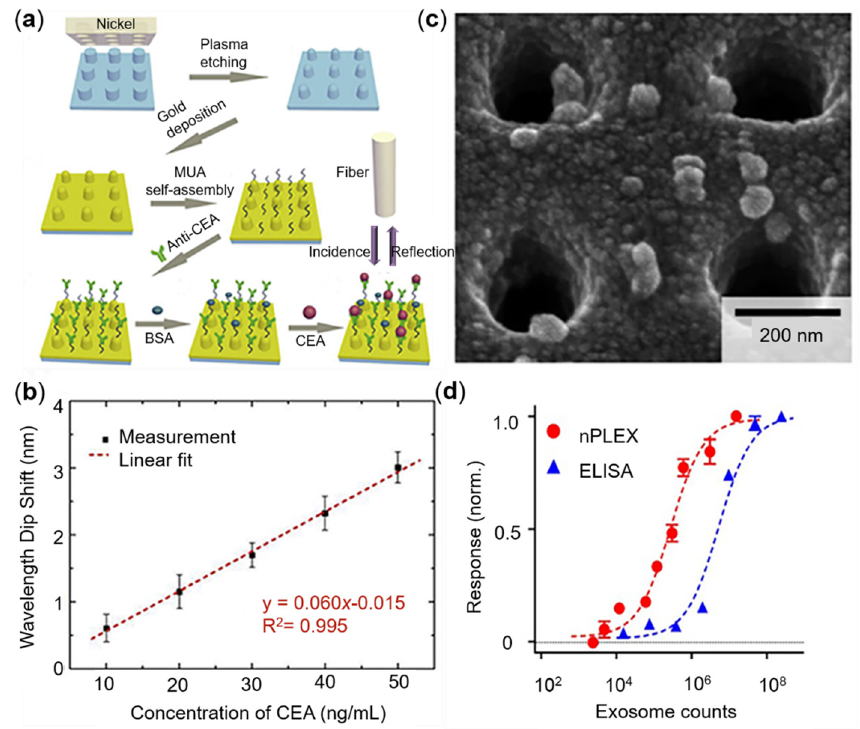
Figure 2. Functionalization of different nanostructures and sensing performance. ( a ) Biofunctionalization of periodic nanorods. ( b ) The linear fitting relationship between wavelength dip shift migration and CEA concentration. ( c ) Scanning electron microscope (SEM) image of exosomes captured by functionalized nanohole arrays. ( d ) Comparison of exosome detection sensitivity between nanohole chip and ELISA. Reprinted ( a , b ) with permission from Reference [76]. Reprinted ( c , d ) with permission from Reference [77].